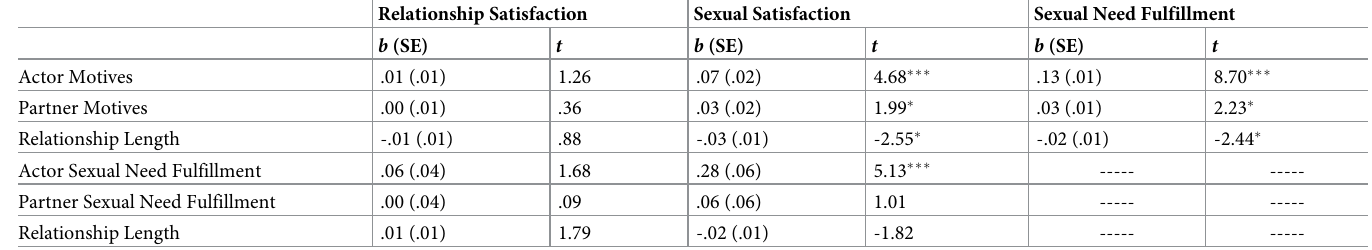
Table 5. Daily associations between actor and partner sexual motives and sexual need fulfillment and daily relationship satisfaction, sexual satisfaction, and sexual need fulfillment. Relationship Satisfaction Sexual